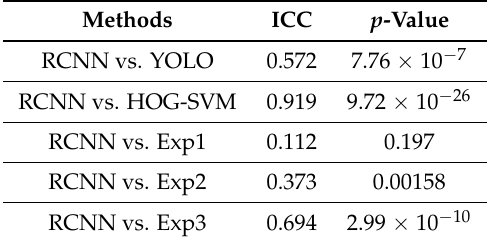
Table 3. Comparison using ICC (intraclass correlation coefficient) methods and